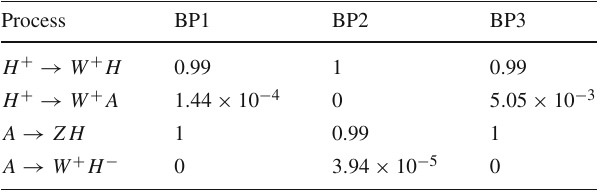
Table 2 Branching ratio of charged and neutral scalar